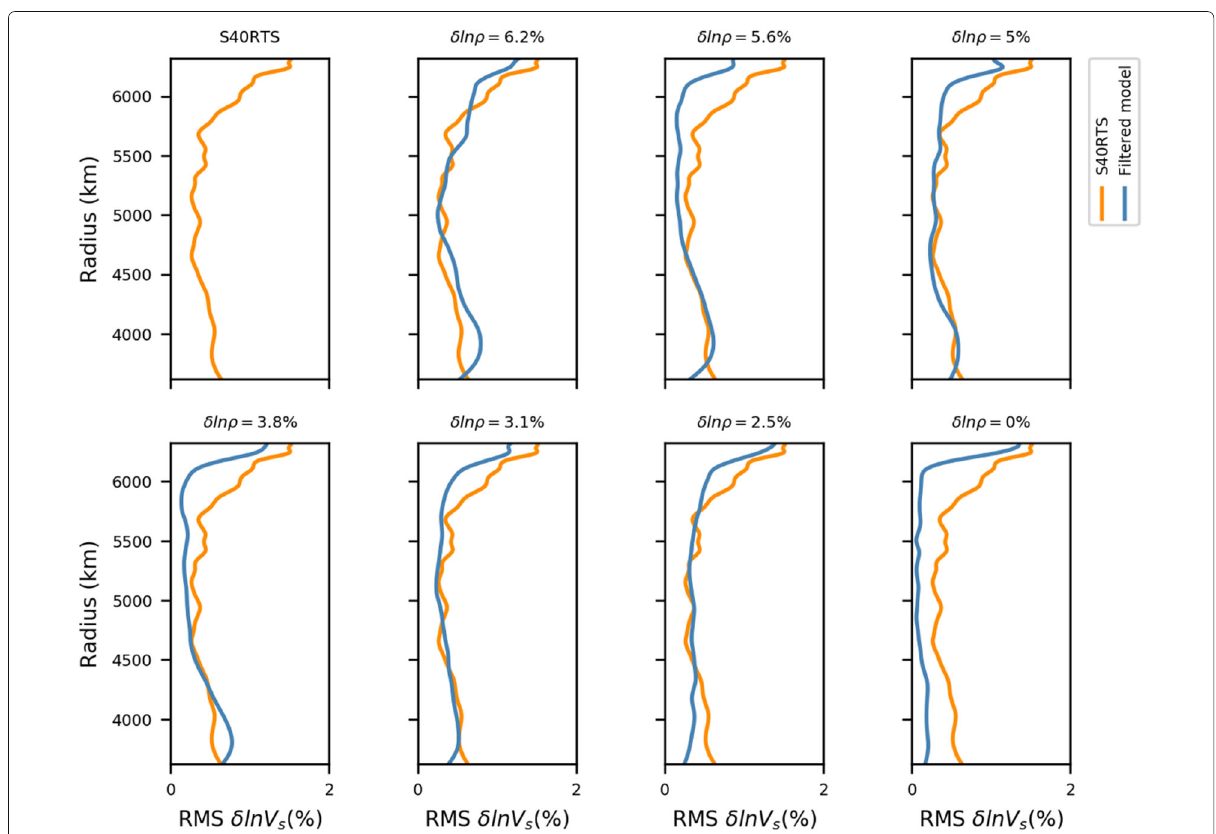
Fig. 9 RMS δ lnV s as a function of radius for S40RTS slices (orange) and dynamic models (blue) after tomographic filtering beneath the African plate